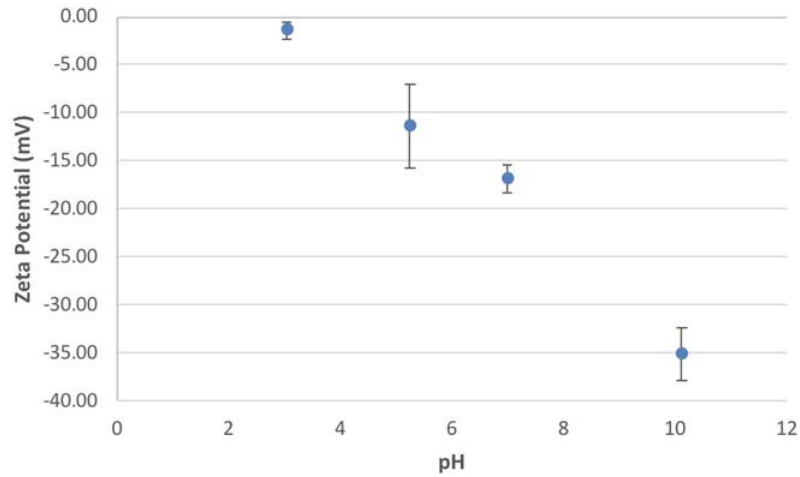
Figure A2. Zeta potential of carbon dots under varying pH levels, while maintaining a constant ion concentration of 10 mM NaCl.